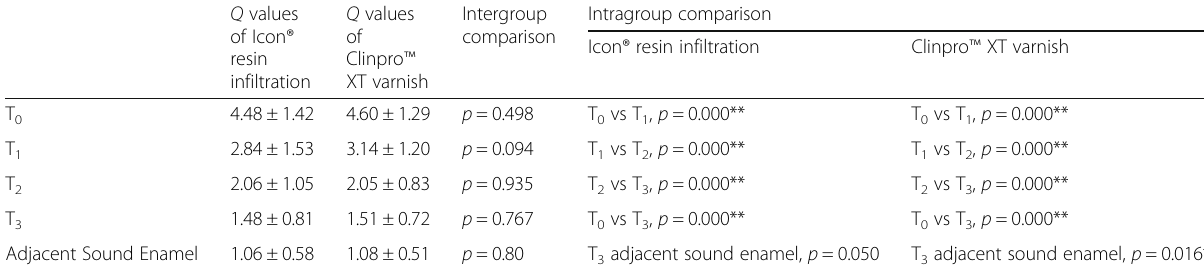
Table 4 Intergroup and intragroup comparison of fluorescence loss ( Q ) values at various time